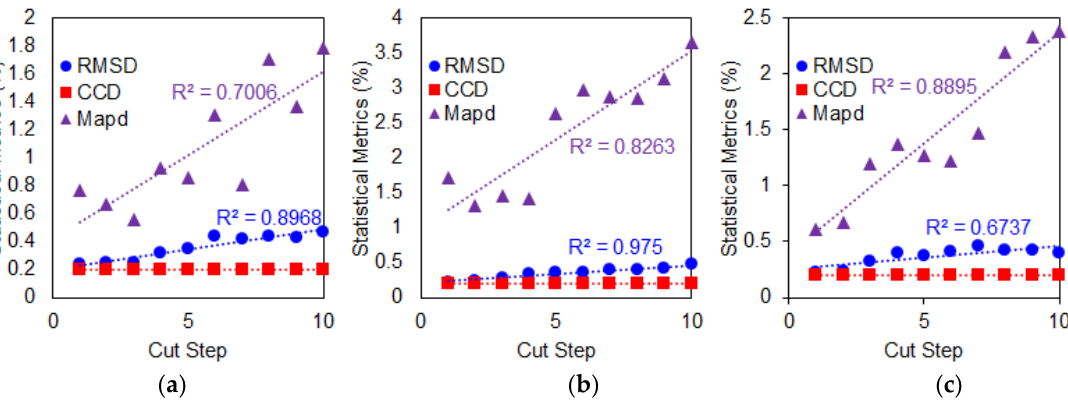
Figure 9. Performance evaluation of steel wire PZT attachment method subject to damage ( a ) Case 1; ( b ) Case 2; ( c ) Case 3